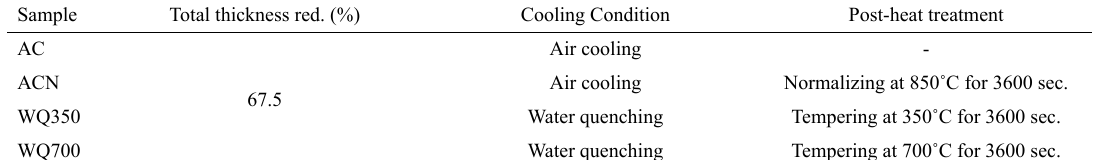
Table 1: The post-heat treatment processing underwent by each one of these specimens. Sample